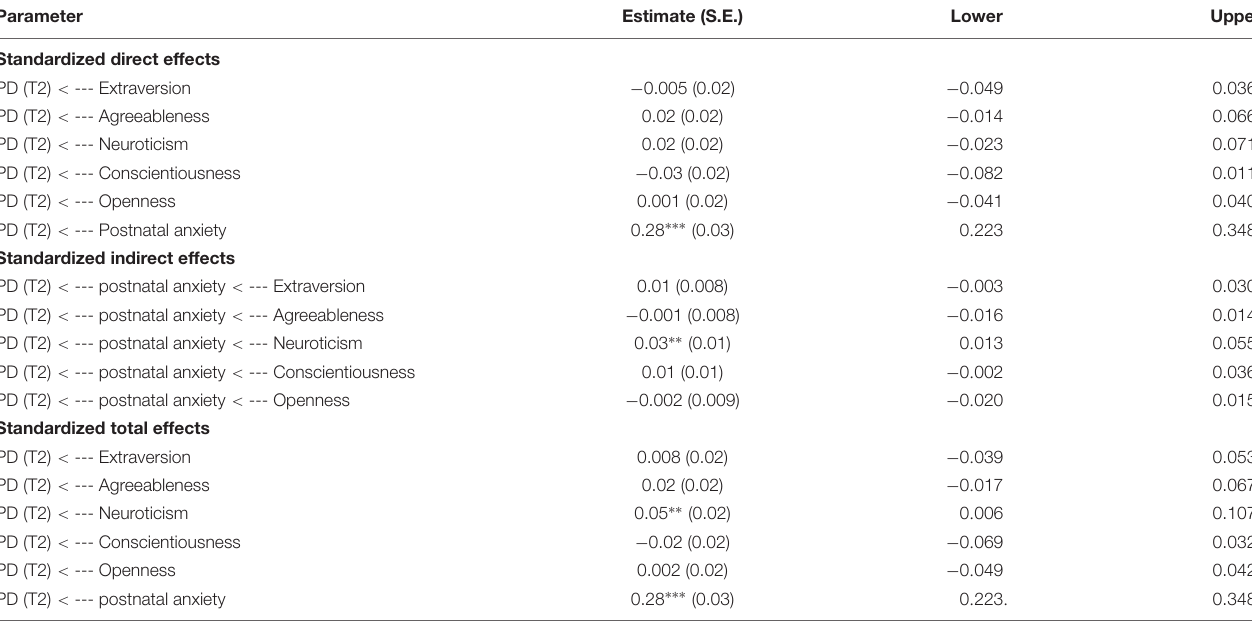
TABLE 3 | Mediation effects of postnatal anxiety in the association between personality traits and postnatal depression at T2 for the entire sample. Parameter Estimate (S.E.) Lower